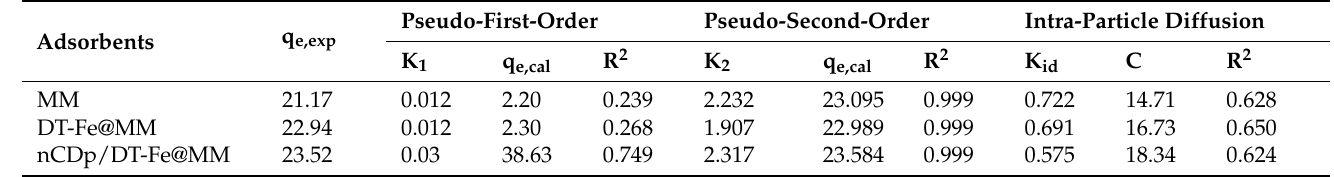
Table 4. Kinetic models fitting parameters for adsorption of BPA on functionalized montmorillonite.